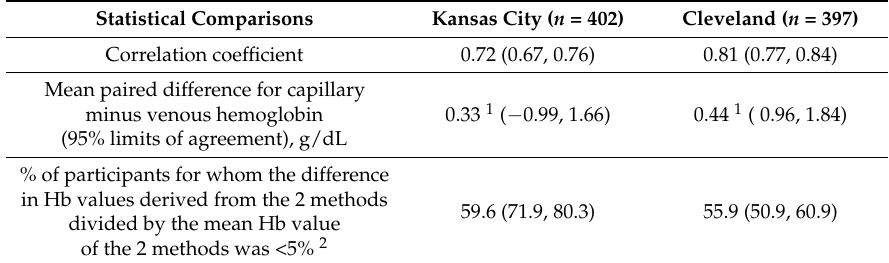
Table 3. Three statistical comparisons of hemoglobin concentrations derived from HemoCue analyses of capillary blood samples with concentrations derived from HemoCue analyses of venous blood samples from toddlers in Kansas City and pregnant women in